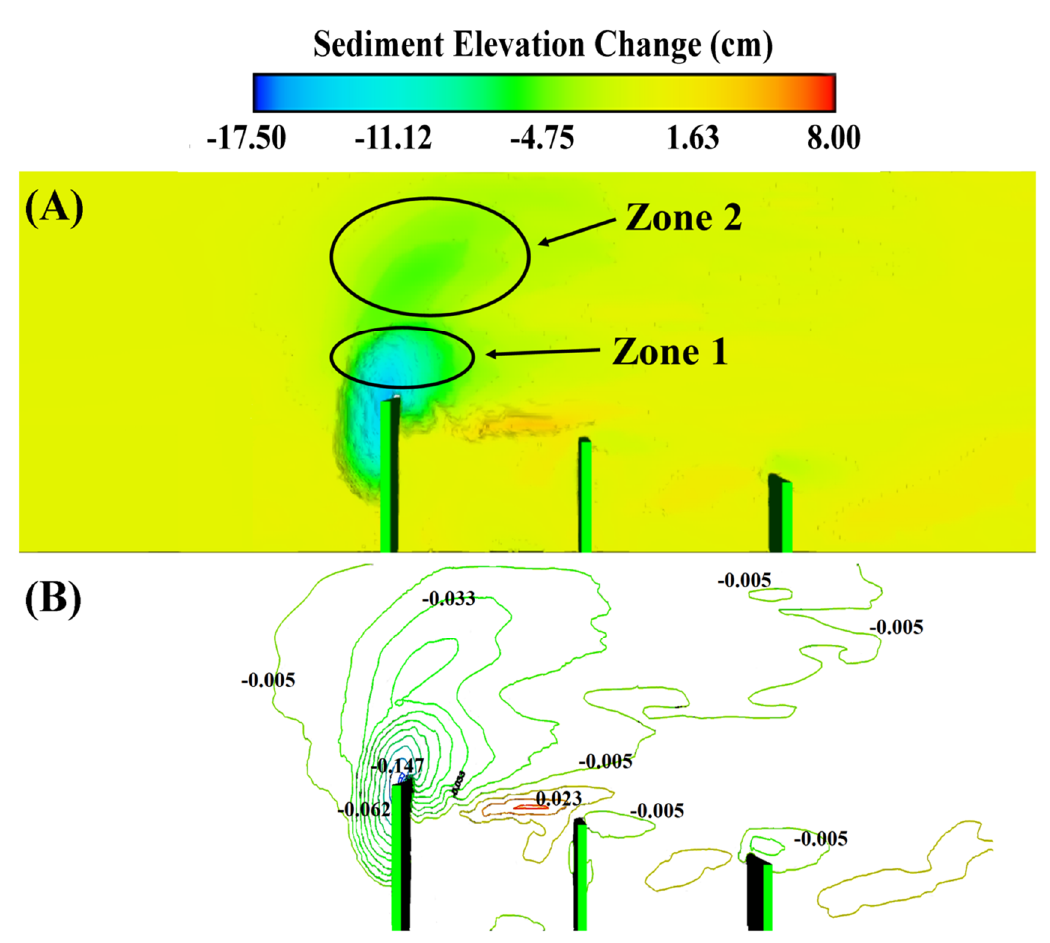
Figure 13. ( A ) Erosion zone 1 and 2, and ( B ) erosion and sedimentation contours in simulation 12.